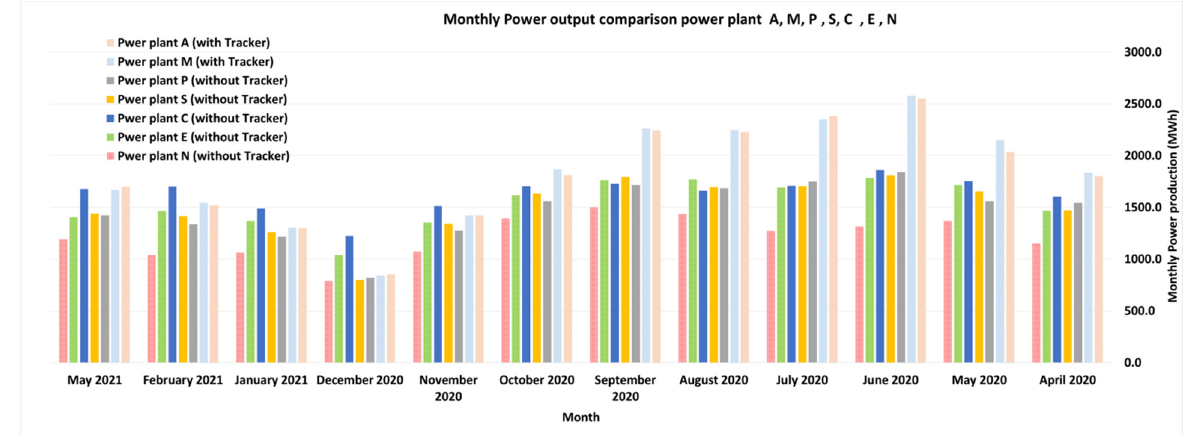
Figure 11. Monthly production of several 10 MW power plants in Yazd and Kerman provinces. Table 6. A comparison between four power plants’ capacity factor, capacity credit and peak time overlap in power plants with/out tracker.